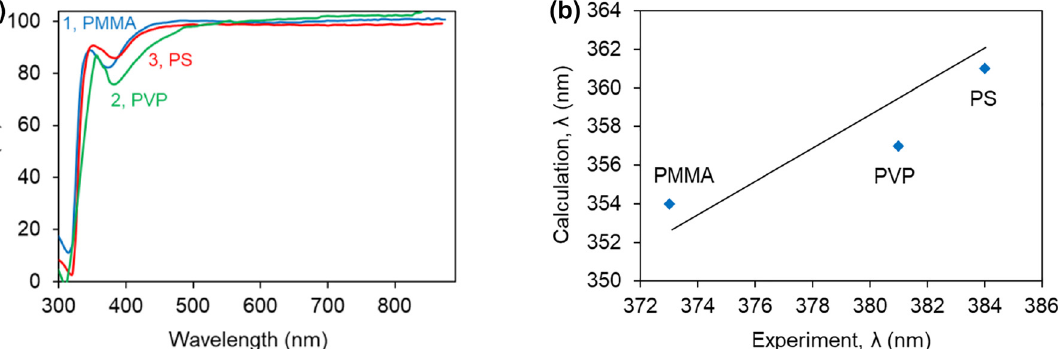
Figure 4: Spectral positions of reflection dips. (a) Reflection spectra of undoped polymers PMMA (1), PVP (2), PS (3) on top of Ag, featuring dips at 𝜆 ∼ 375 nm. (b) Calculated versus experimental wavelengths of the dips in the reflection spectra.